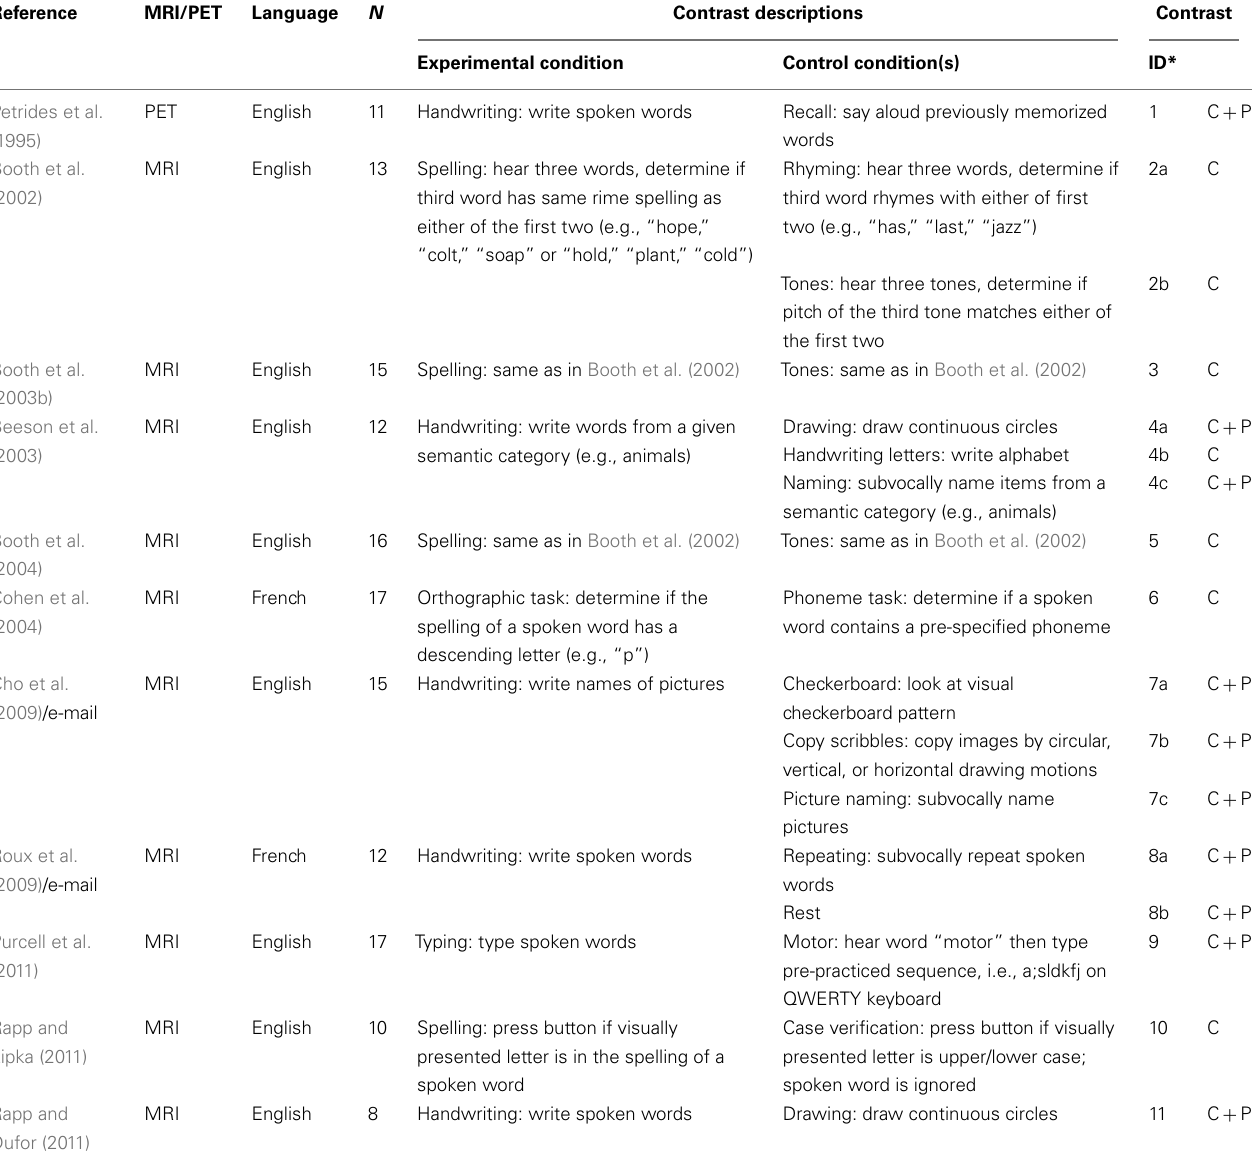
Table 1 | Meta-analysis